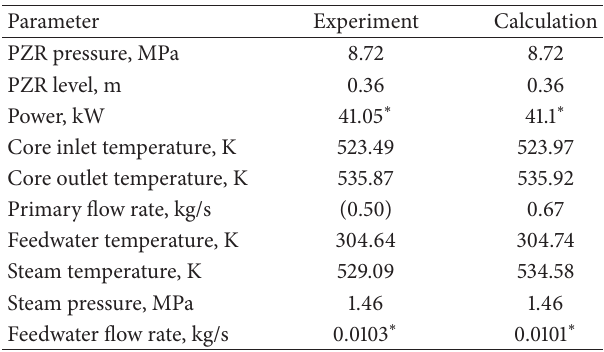
Table 1: Initial conditions for natural circulation test.